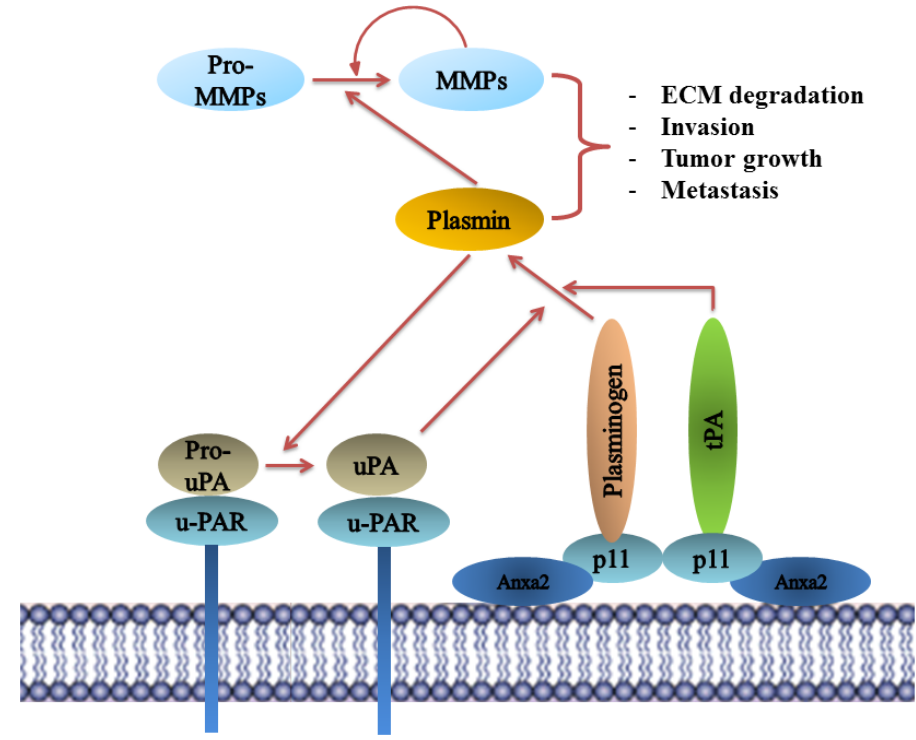
Figure 3. Experimental model of plasmin regulation by cell surface annexin A2 and S100A10. The heterotetrameric complex consists of two copies of annexin A2 and one copy of the S100A10 dimer. AIIt binds the tissue-plasminogen activator tPA and plasminogen at the carboxyl-terminal lysine residue of the S100A10 subunit. The annexin A2 subunit does not bind tPA or plasminogen but serves as cell surface receptor for S100A10. The urokinase-plasminogen activator is bound to its receptor (uPAR) and forms the uPA/uPAR complex that colocalizes with AIIt. The co-localization of the plasminogen activators and plasminogen by AIIt results in accelerated cleavage of plasminogen into plasmin. Plasmin activates pro-MMPs (matrix metallo-proteases) into active MMPs and further activates pro-uPA into active